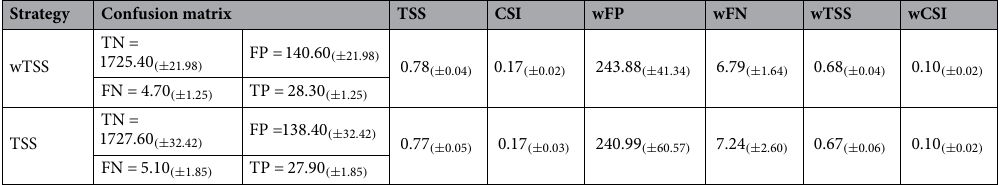
Table 1. Results on the test set obtained by using the TSS-ensemble and wTSS-ensemble strategies. The entries are the average values of the scores over 10 runs of the network for 10 random initializations of the weights. The standard deviations are also